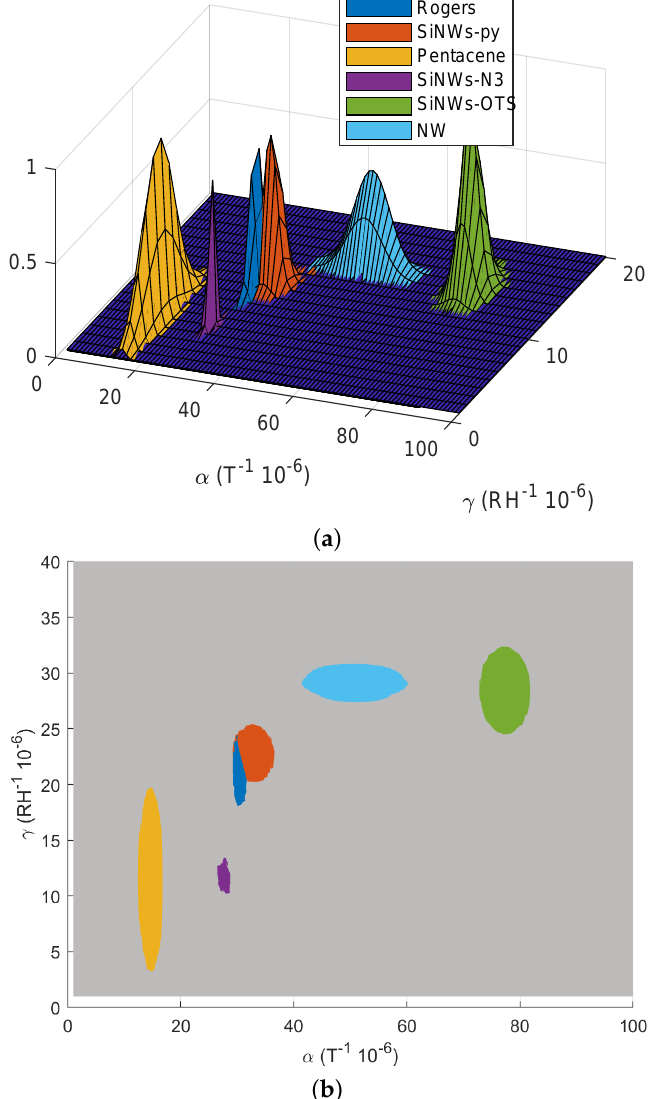
Figure 12. ( a ) Three-dimensional representation of the 6 samples characterized in practice using the climatic chamber and the RF approach. ( b ) Top-view of the Gaussian